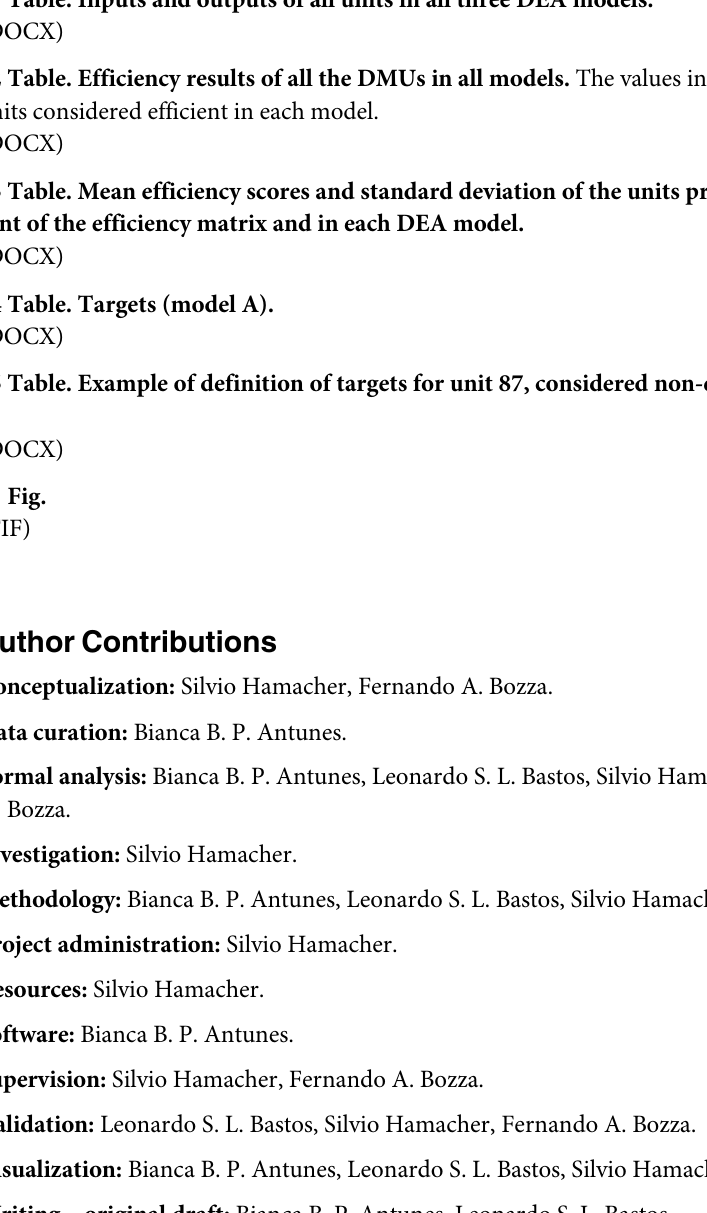
S1 Table. Inputs and outputs of all units in all three DEA models. S2 Table. Efficiency results of all the DMUs in all models. The values in grey represent the units considered efficient in each model. S3 Table. Mean efficiency scores and standard deviation of the units present in each quad- rant of the efficiency matrix and in each DEA model. S4 Table. Targets (model A). S5 Table. Example of definition of targets for unit 87, considered non-efficient in Model